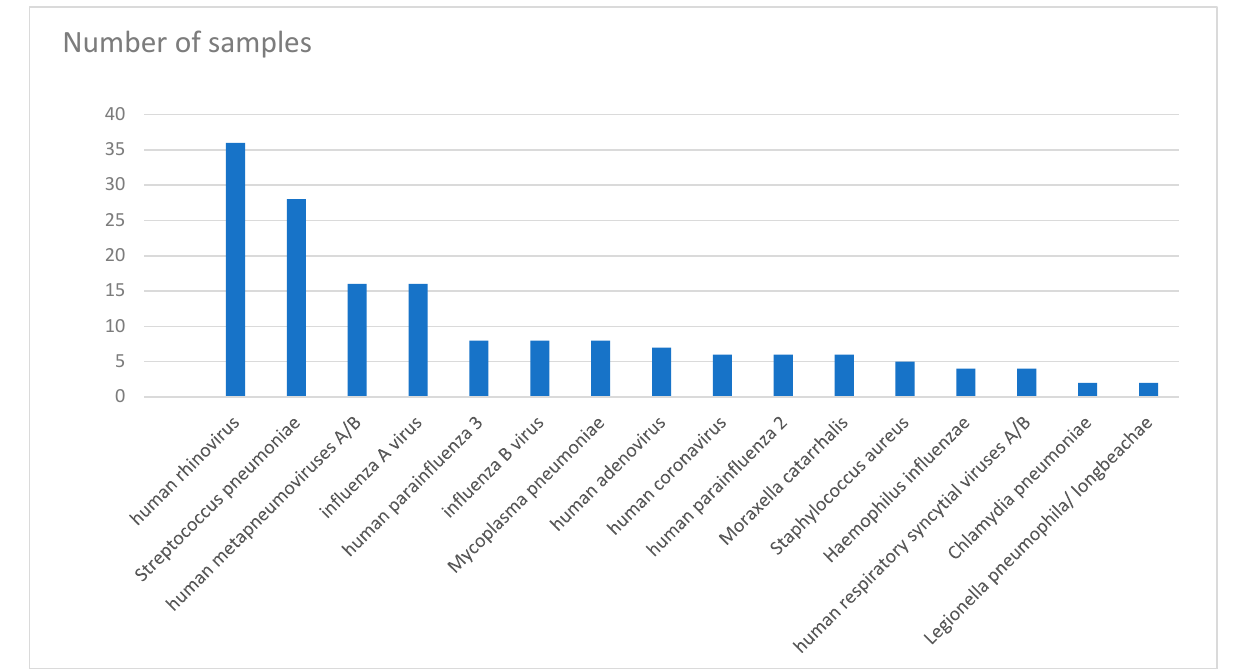
Figure 1. Frequency of isolated pathogens from patients recruited in this study. Table 1. Number of detections for each pathogen.